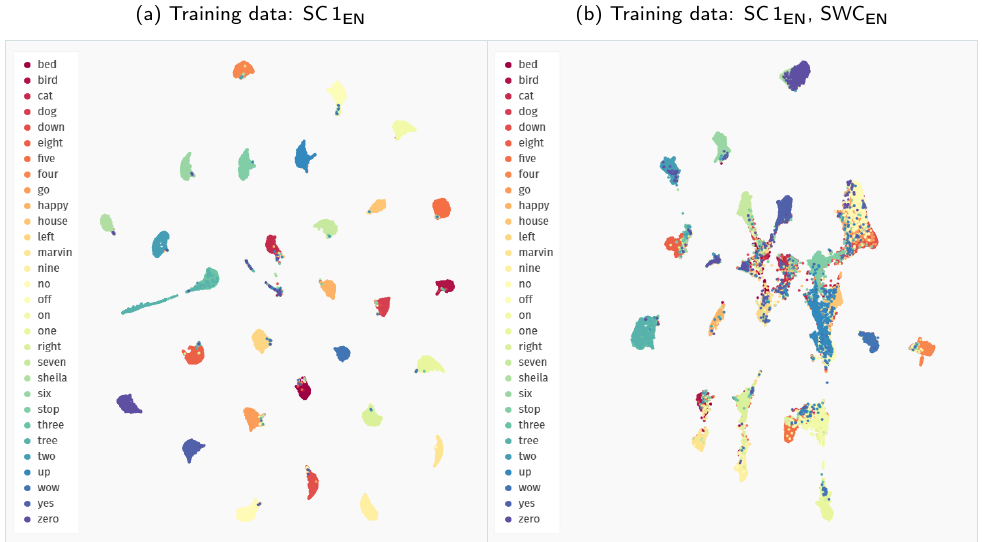
Figure 5. Comparison of the UMAP visualisations of the Speech Commands training examples (SC1 EN ) processed through the Siamese embedder: ( a ) embeddings generated with a model trained only on the Speech Commands data; ( b ) embeddings generated with a model trained on recordings both from the Speech Commands and the Spoken Wikipedia Corpus datasets. (We employ a zero minimum distance between embedded points. Other visualisation settings use standard values of the umap-learn Python package, i.e., 15 neighbours with a Euclidean metric for Uniform Manifold Approximation and